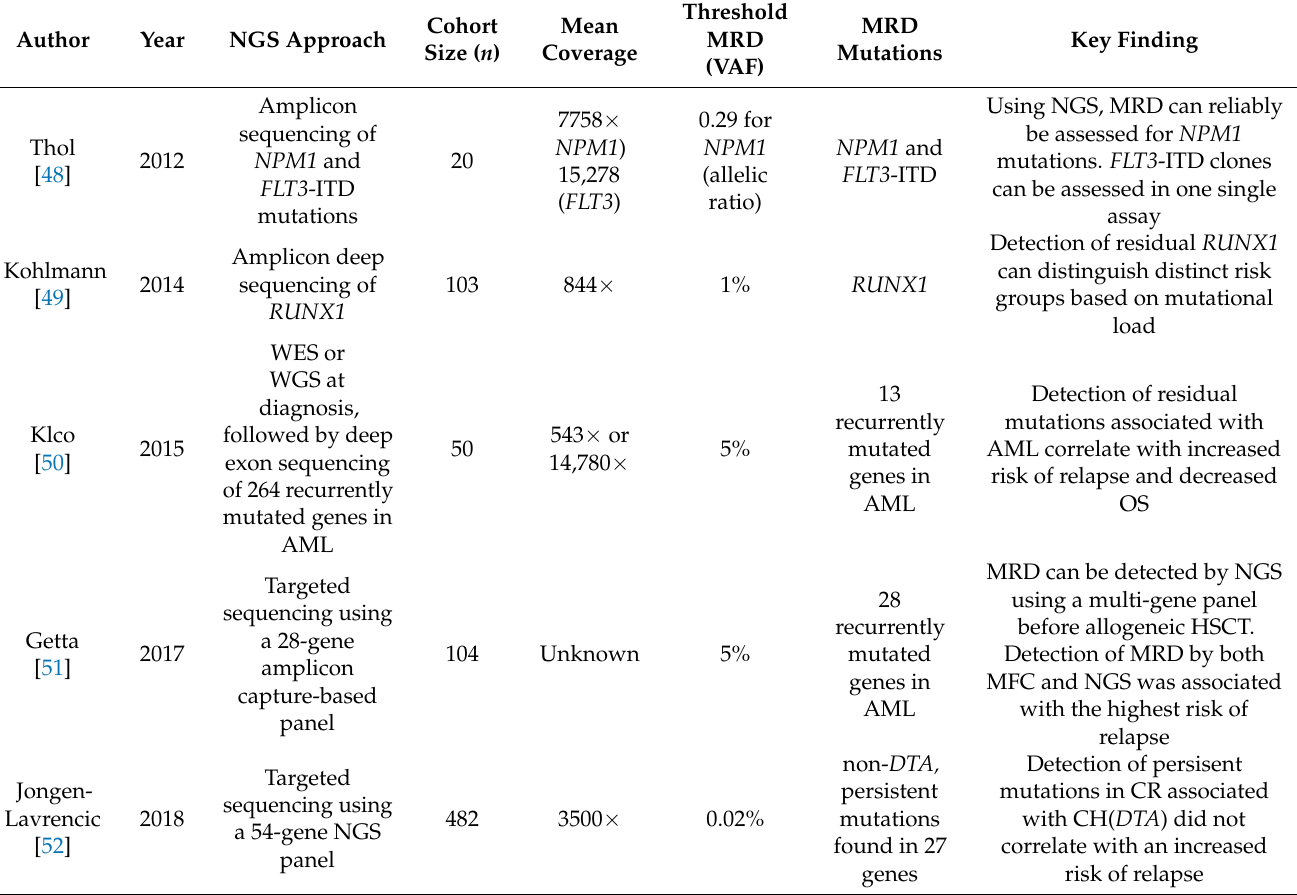
Table 1. Next Generation Sequencing Studies for MRD Detection in adult